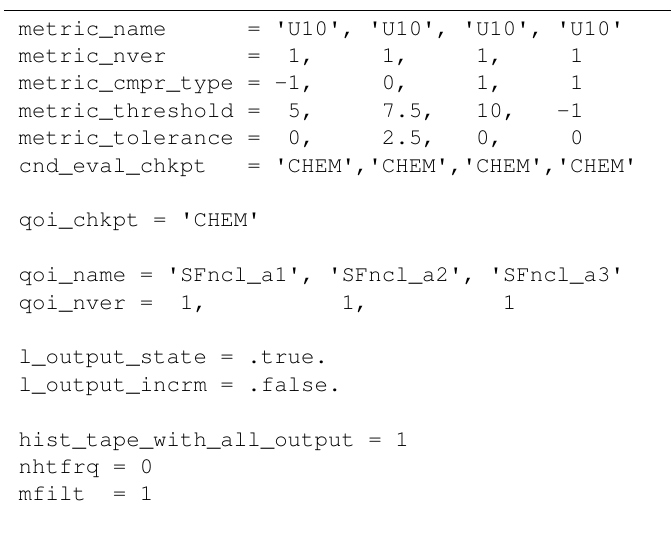
Table 3. Namelist setup used in the composite analysis presented in Sect.